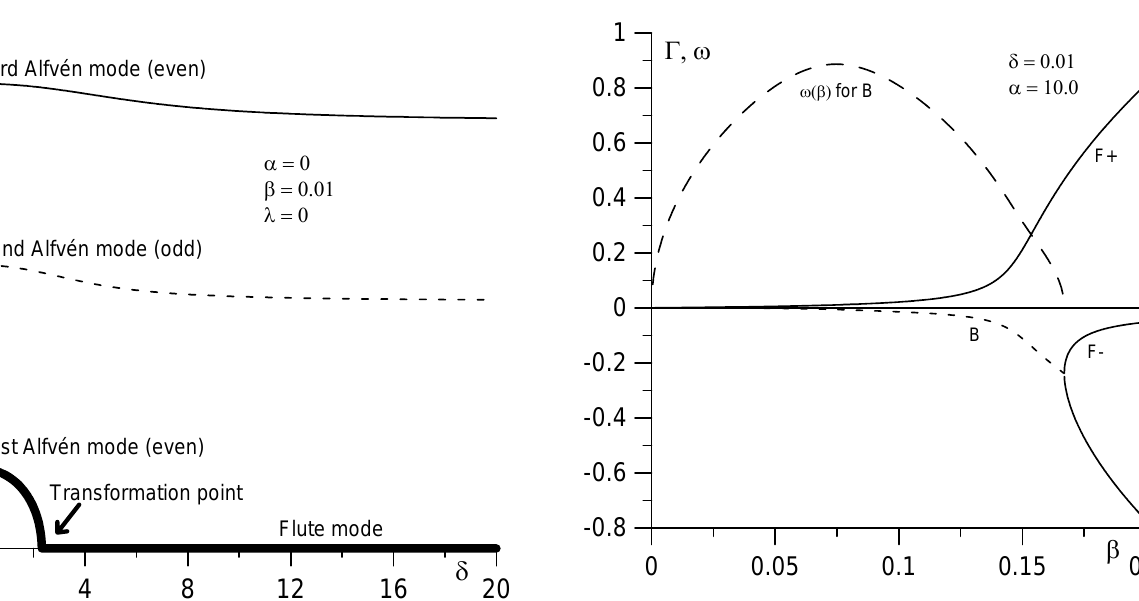
Fig. 7. Dependence of spectrum on ionospheric conductivity for β = 0 . 01. The first Alfv´en mode exists only at δ< 2 . 35 (in day sec- tor). Figure 7. Dependence of spectrum on ionospheric conductivity for 01.0 =β . The first Alfvén mode exists only at 35.2 <δ (in day sector).